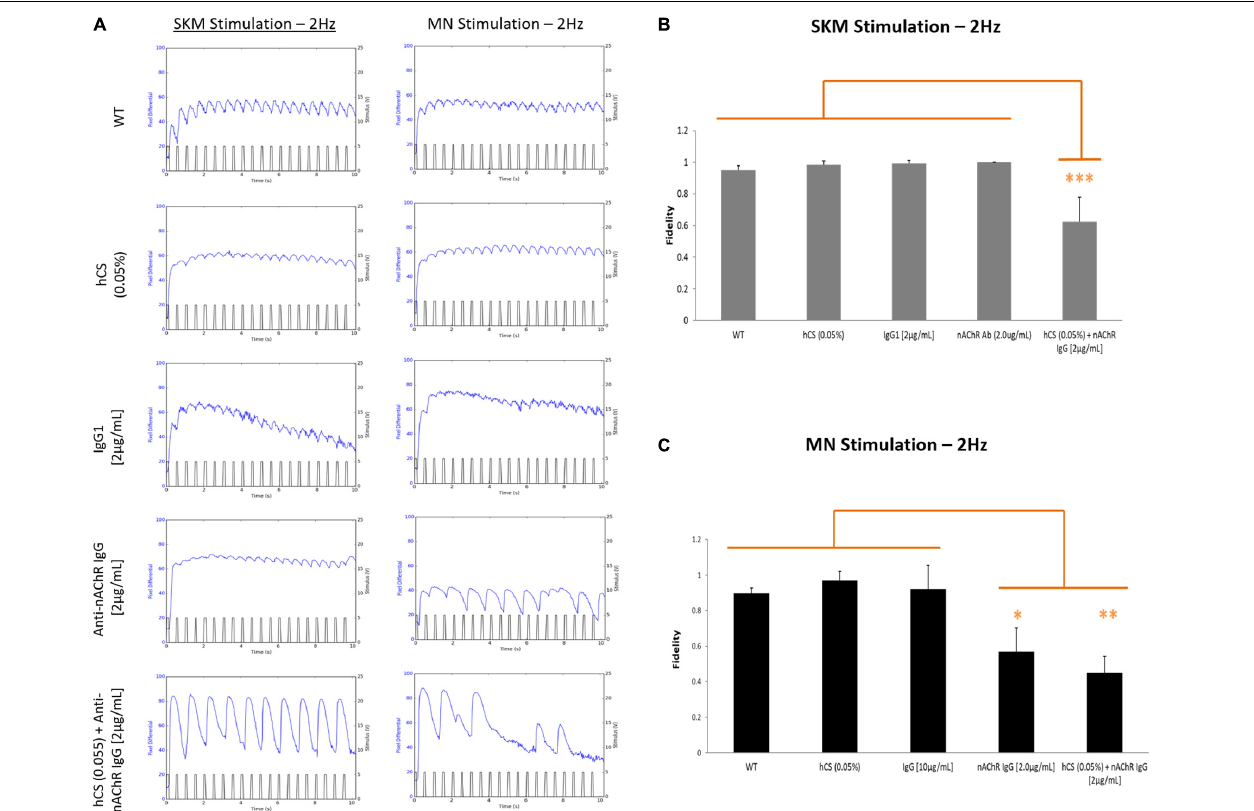
FIGURE 6 | Complement activation reduces SKM and NMJ fidelity. SKM fidelity at 2 Hz under direct and indirect stimulation after incubation with 0.05% hCS ( N = 2, 6 replicates), non-specific IgG1 ( N = 3, 7 replicates), anti-nAChR Ab and a combination of 0.05% hCS ( N = 2, 4 replicates) and 2 µ g/mL of anti-nAChR Ab ( N = 2, 4 replicates). (A) Representative stimulation traces generated at 2 Hz from both direct (SKM stimulation) and indirect (MN stimulation) of a myotube under the five conditions. Mean fidelity of peaks under direct (B) and indirect (C) stimulation. Significant reduction of fidelity with antibody and complement under direct and indirect stimulation and antibody only under indirect stimulation. Statistics: Fisher LSD Method ∗ p < 0.050; ∗∗ p < 0.020; ∗∗∗ p <